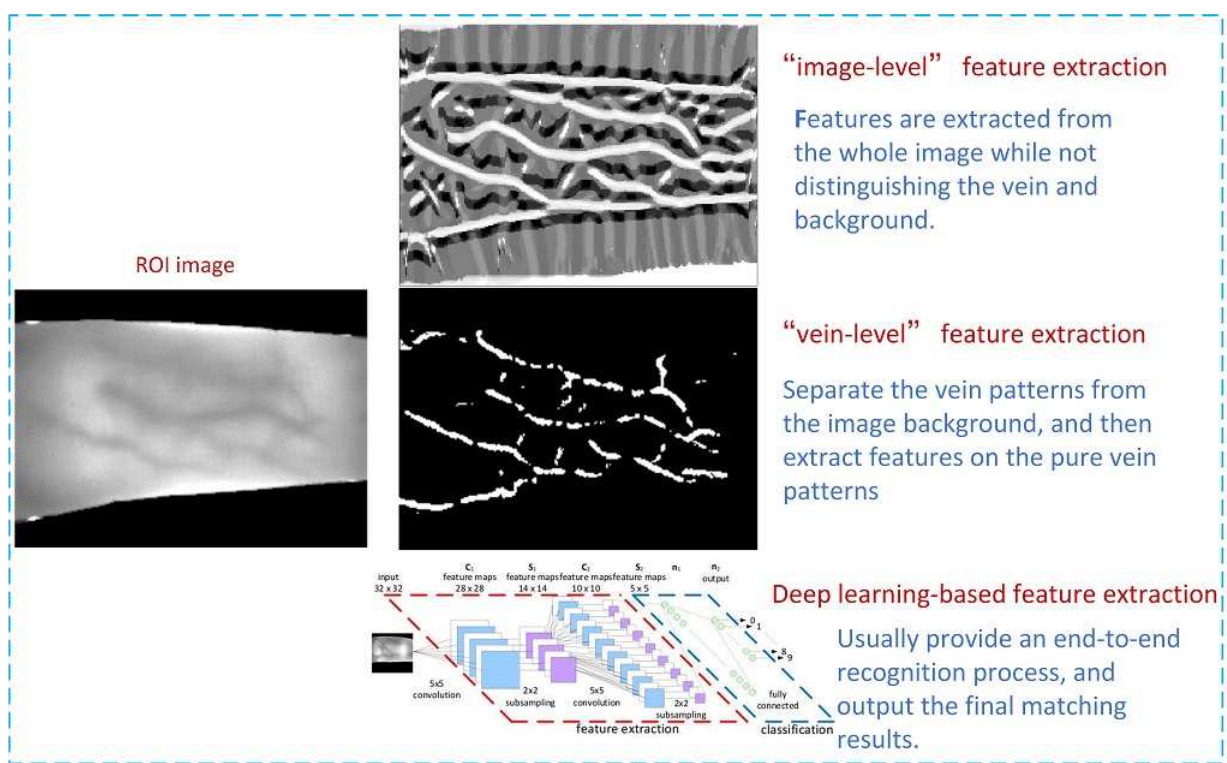
Figure 1. Illustration of different ways of feature extraction for finger vein images.